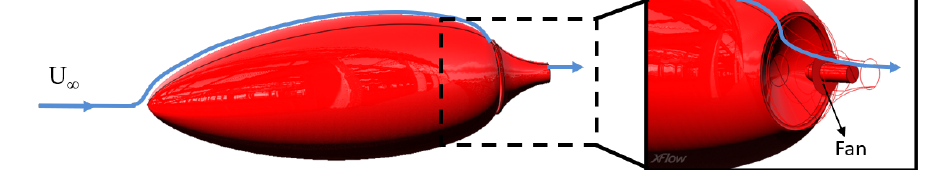
Figure 9. Goldschmied geometry model.